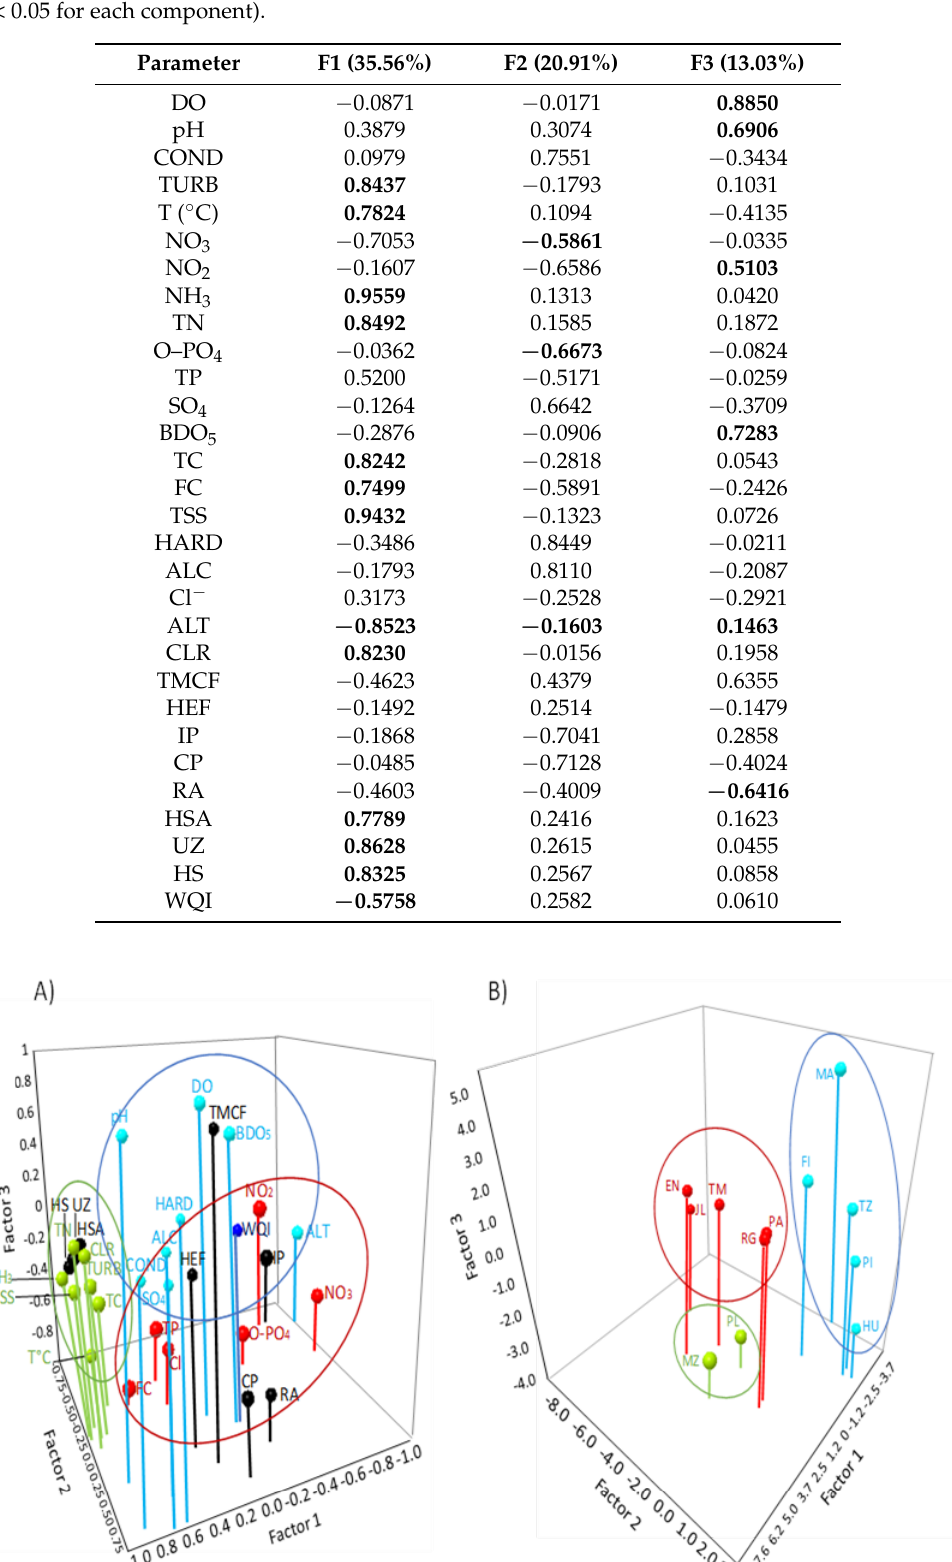
Table 1. Factor loadings and variance (%) for components F1, F2, and F3. Figures in bold are significant ( p < 0.05 for each component).